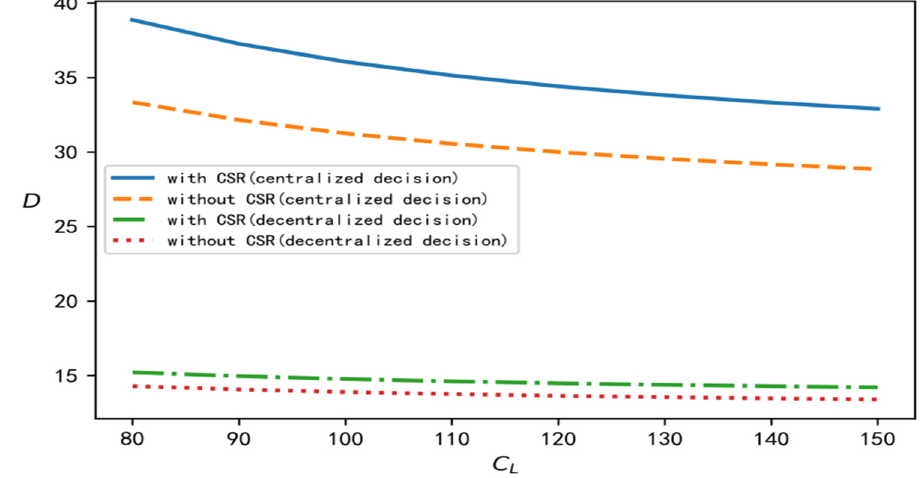
Figure 3. Change trend of demand.